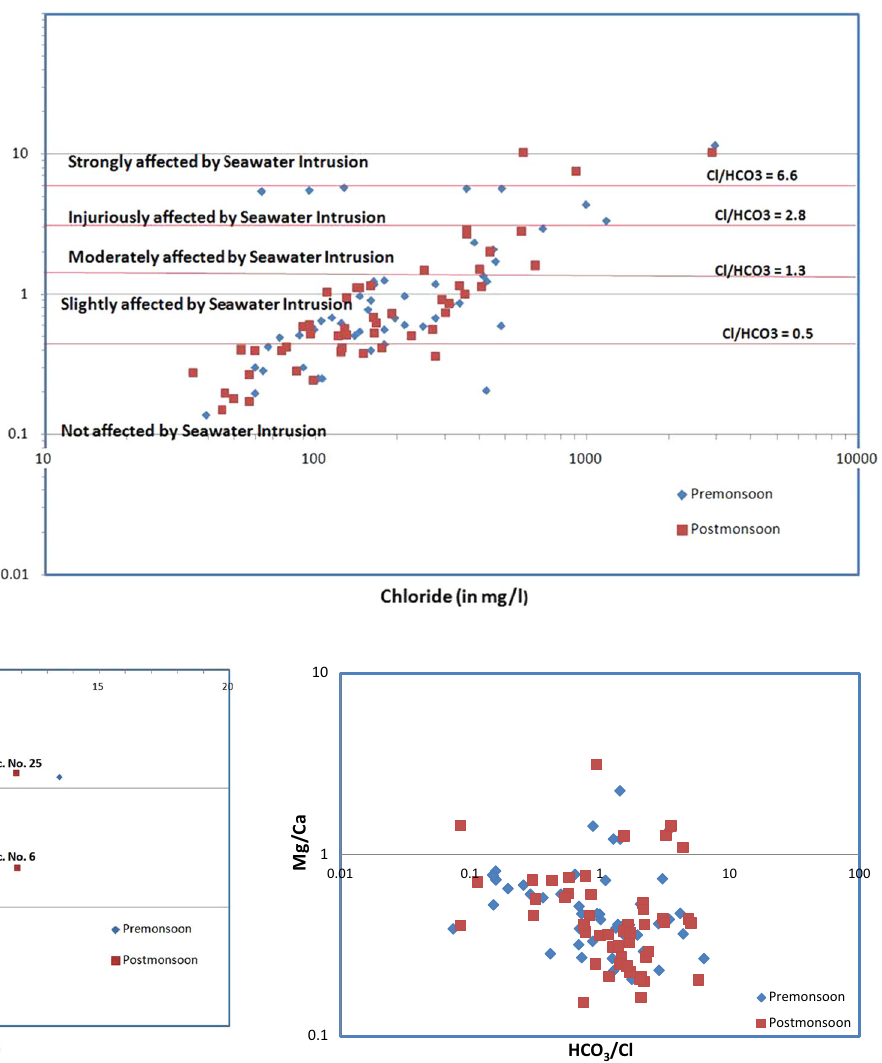
Fig. 7 Relationship between Cl/HCO groundwater samples